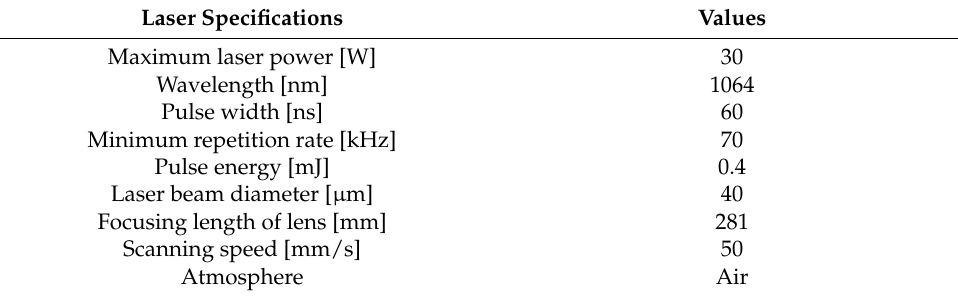
Table 1. Main characteristics of the employed laser system.